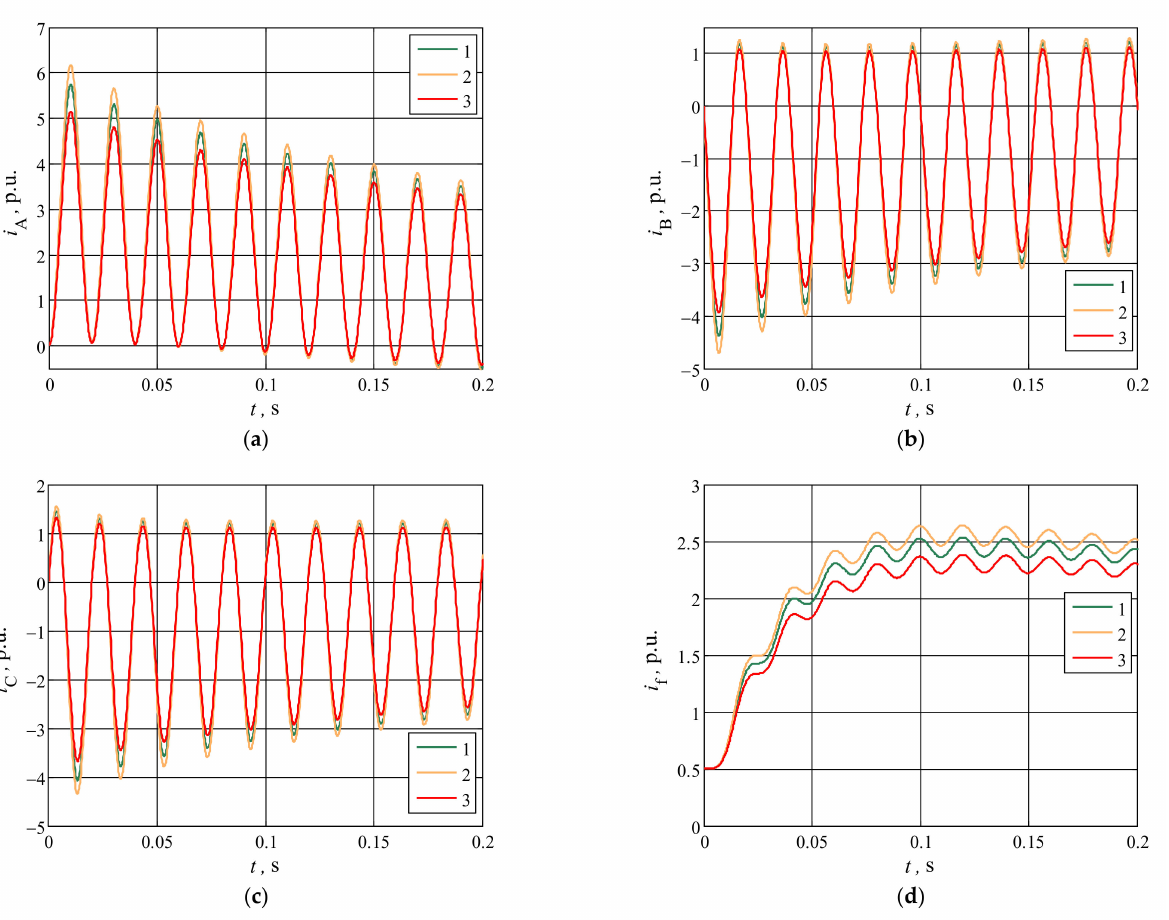
Figure 6. Comparison of the waveforms of stator winding currents i A ( a ), i B ( b ), i C ( c ) and field current i f ( d ) at the three- phase short-circuit calculated by FEM for various inductance values of the end windings determined: from 1—3D model, 2—acc. to the Abramov formula, 3—acc. to the Cioc and Nico